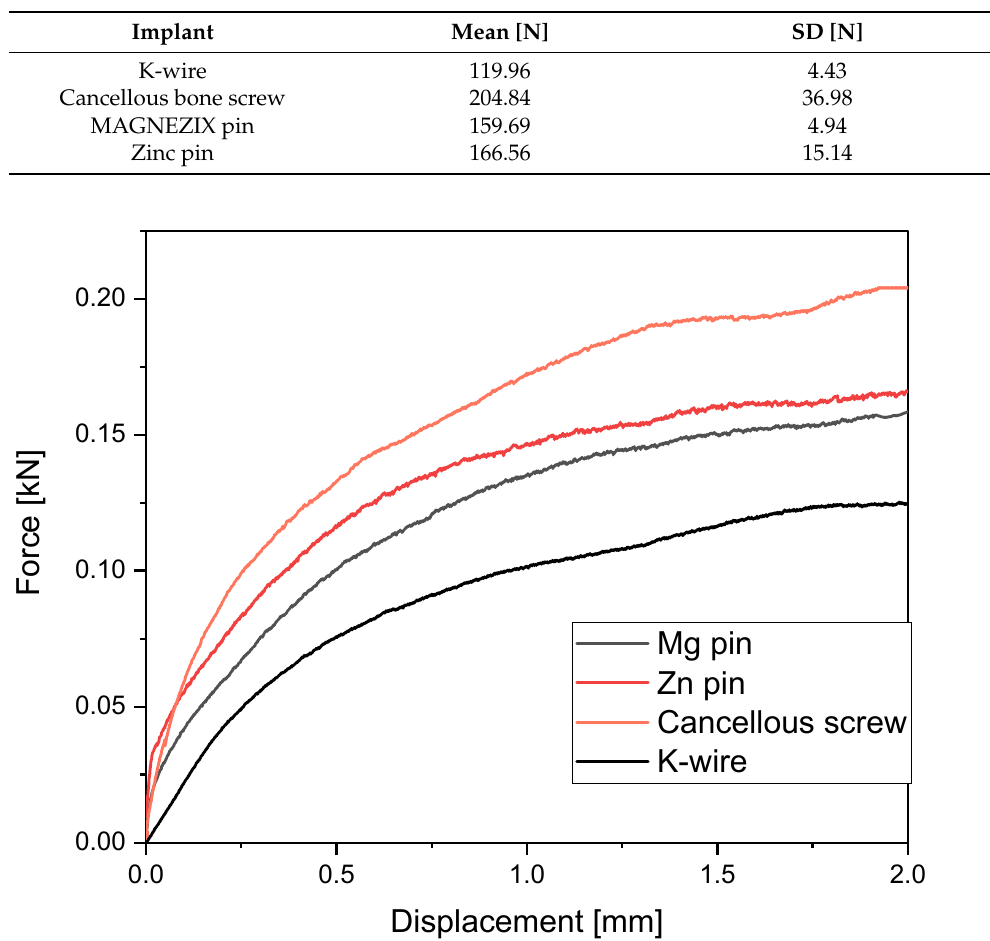
Figure 2. This figure shows the average force-displacement curves of the MAGNEZIX pin, the zinc pin, the cancellous screw, and the K-wire under quasi-static